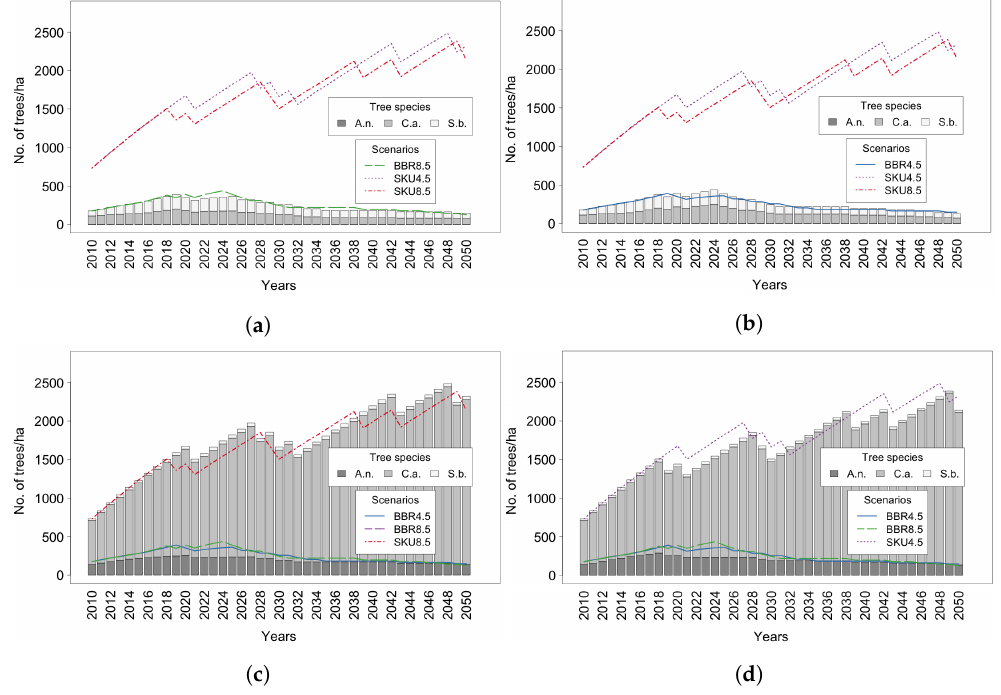
Figure 8. Distributions of Tree species A.n., C.a., and S.b. in ( a ) BBR RCP 4.5 Scenario, ( b ) BBR RCP 8.5 Scenario, ( c ) SKU RCP 4.5 Scenario, and ( d ) SKU RCP 8.5